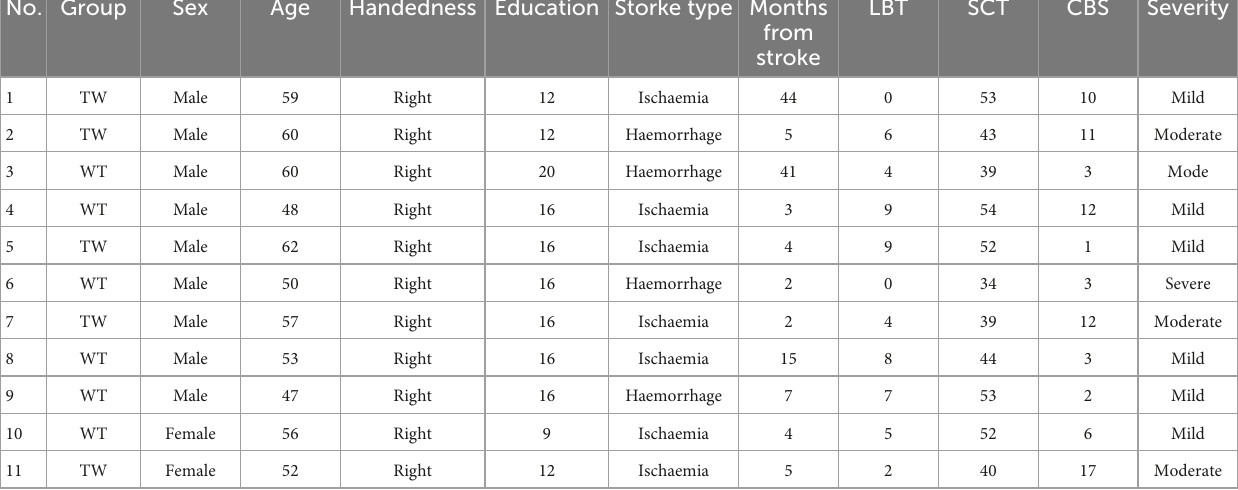
TABLE 1 Participant